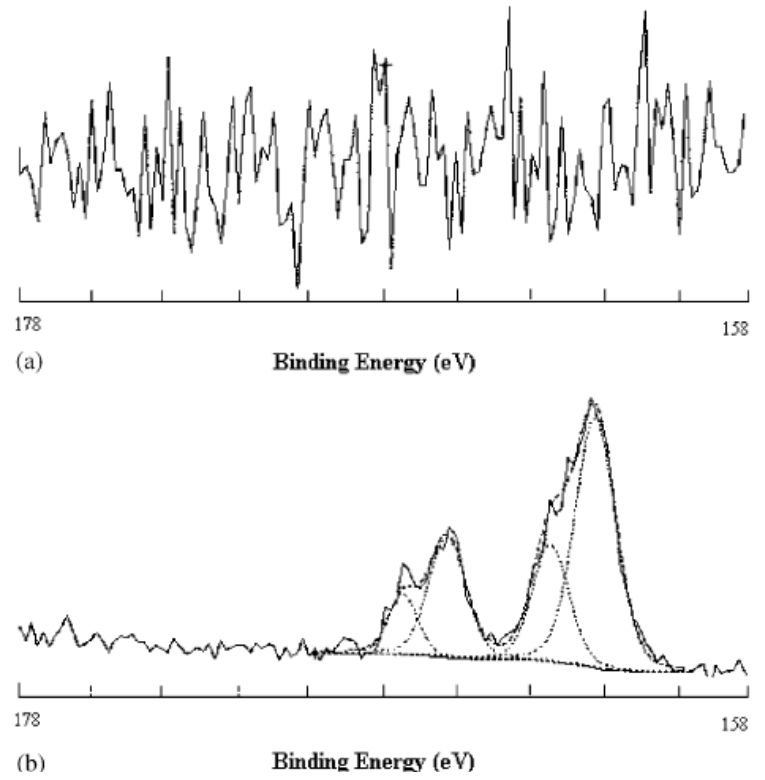
Figure 6. High resolution spectra of S2p signal recorded by X-ray photoelectron spectroscopy from unmodified ( a ) and thiosulphate-substituted plasticized PVC sheet ( b ) (Reprinted with permission from [82]. Copyright 2002